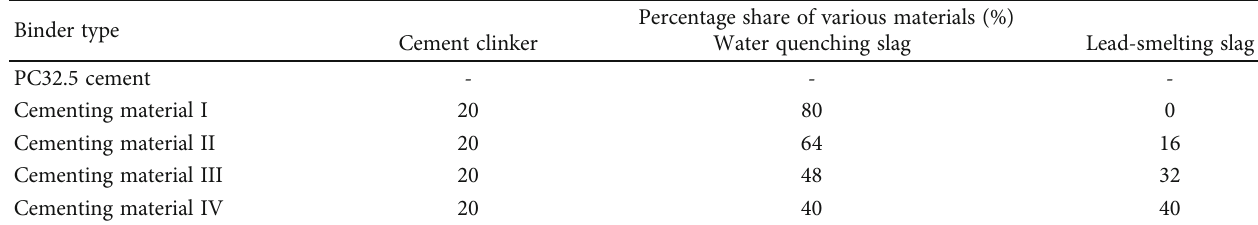
Table 5: Percentage contents of cementing